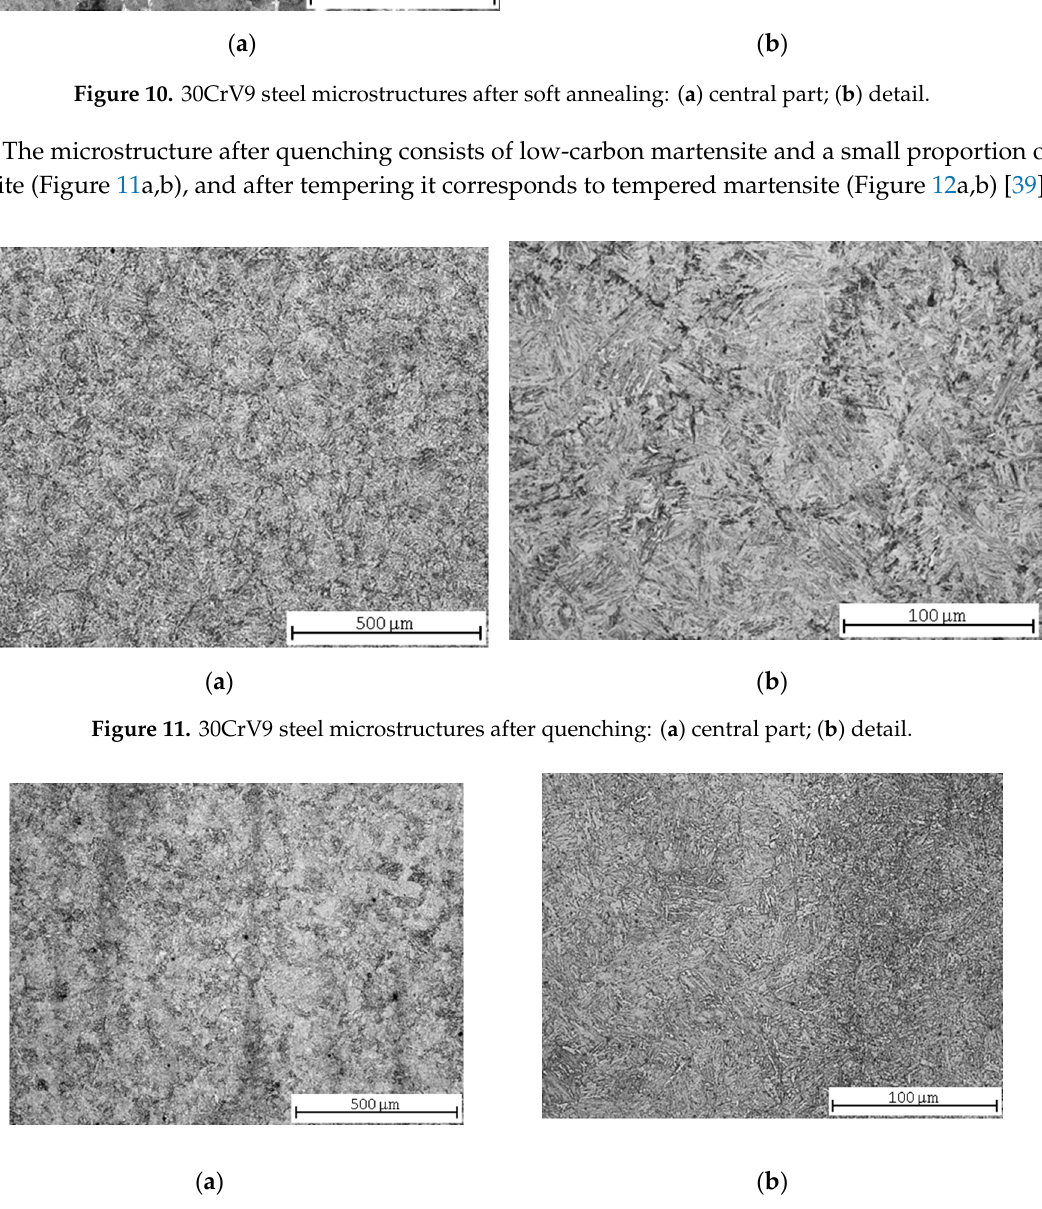
Figure 12. Quenched and tempered 30CrV9 steel microstructures: ( a ) central part; ( b ) detail.